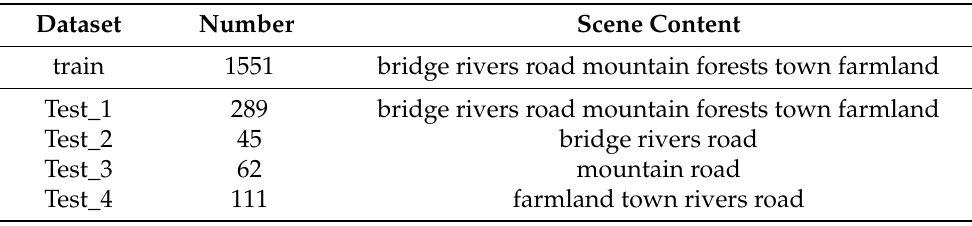
Table 1. The information of images involved in the SAR-to-optical